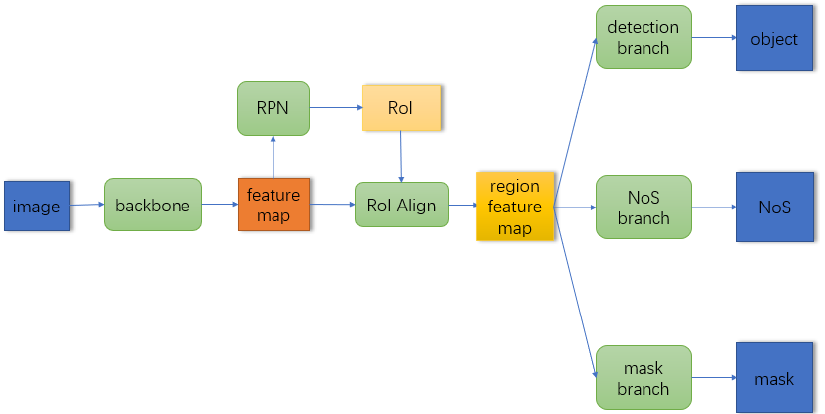
Figure 1. Main architecture of NoS R-CNN. This figure is from [3].